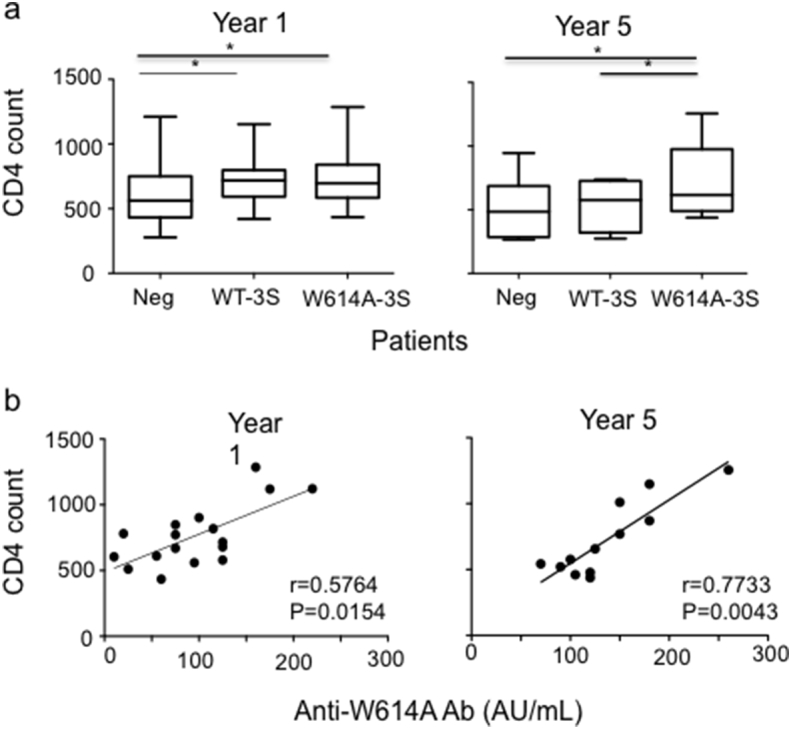
W614A-3S NAbs are associated with high CD4+ T-cell counts and continued ALT controller status. (A) CD4+ T-cell counts in LTNP patients subdivided into three groups according to their capacity to produce W614A+-3S NAbs, non-neutralizing WT-3S+ Ab only, or neither subtype (Neg). Data are done at years 1 and 5 after cohort entry. (B) The positive correlation between CD4+ T-cell counts and W614A-3S Abs titer at years 1 and 5 after cohort entry.